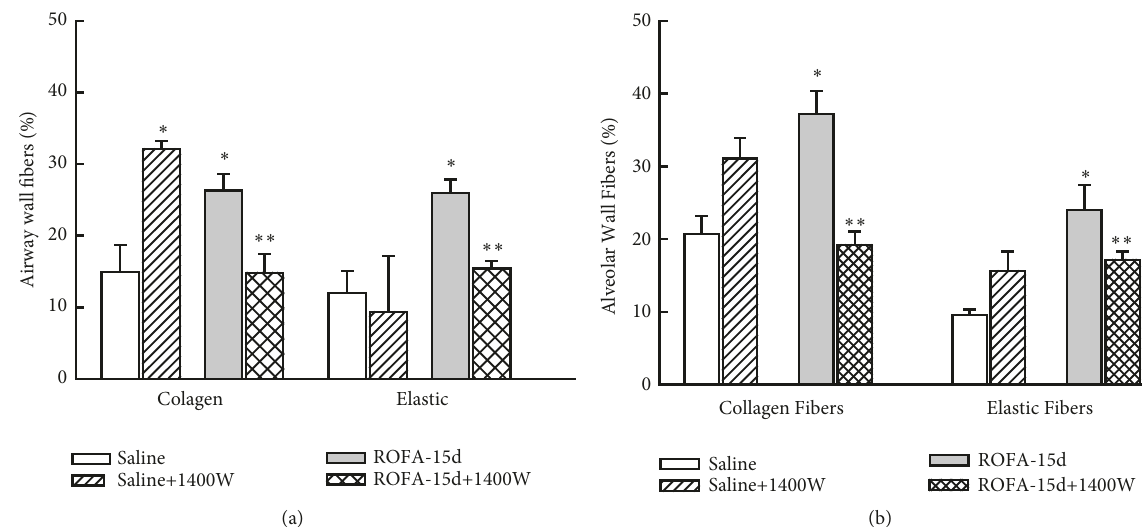
Figure 4: Lung remodeling: this figure represents the mean and SEM values of both collagen and elastic fiberscontentaround airways (a) and in alveolar wall (b). The ROFA instillations increased the airway and parenchyma extracellular matrix fibers deposition compared to control, and the iNOS inhibition reduced these responses. ∗ p < 0.05 compared with saline groups; ∗∗ p < 0.05 compared with animals that received ROFA and vehicle treatment.